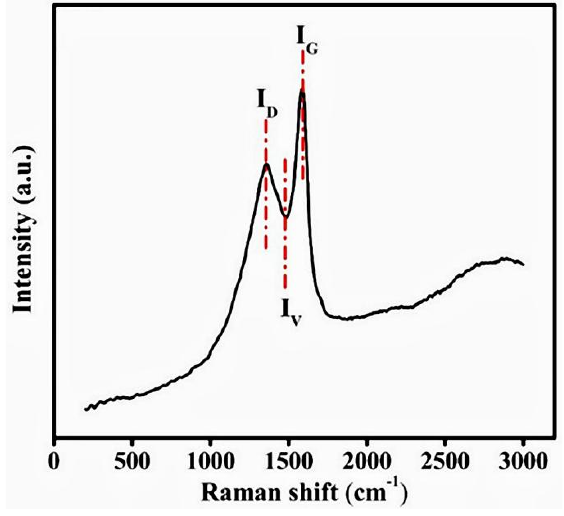
Figure 15. The Raman spectroscopy of rice husk biochar [124]. Reprinted with permission from Kaikai Zhang et al. (2018). Copyright 2018,